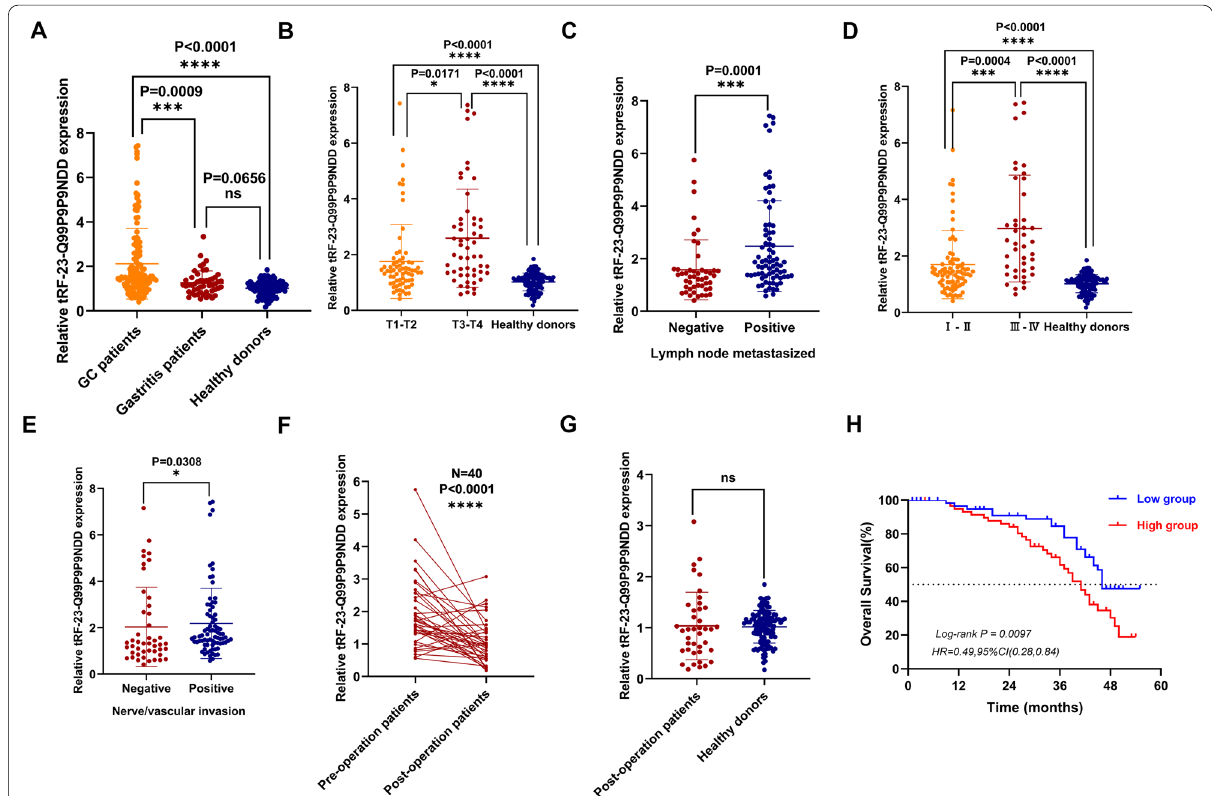
Fig. 3 Clinical value and prognostic role of tRF-23-Q99P9P9NDD in GC serum. A The expression levels of tRF-23-Q99P9P9NDD in serum samples from GC patients (n 124), gastritis patients (n 50), and healthy donors (n 119). B The expression level of tRF-23-Q99P9P9NDD in = = = different stages of the depth of tumor invasion and healthy donors (T1–T2: n 69, T3–T4: n 55, healthy donors: n 119). C The expression = = = levels of tRF-23-Q99P9P9NDD in serum of GC patients with (n 76) or without lymph node metastasis (n 48). D The expression levels of = = tRF-23-Q99P9P9NDD in serum of stage I–II GC patients (n 82), stage III–IV patients (n 42), and healthy donors (n 119). E The expression level of = = = tRF-23-Q99P9P9NDD in serum of GC patients with (n 78) or without nerve/vascular invasion (n 46). F Changes in the serum expression levels of = = tRF-23-Q99P9P9NDD in 40 GC patients before and after surgery. G Differences in the expression levels of tRF-23-Q99P9P9NDD in the postoperative serum of GC patients and healthy donors. H Kaplan–Meier curve analysis of the relationship between the expression levels of tRF-23-Q99P9P9NDD and the survival of GC patients. *P < 0.05; **P < 0.01; ***P < 0.001; ****P <